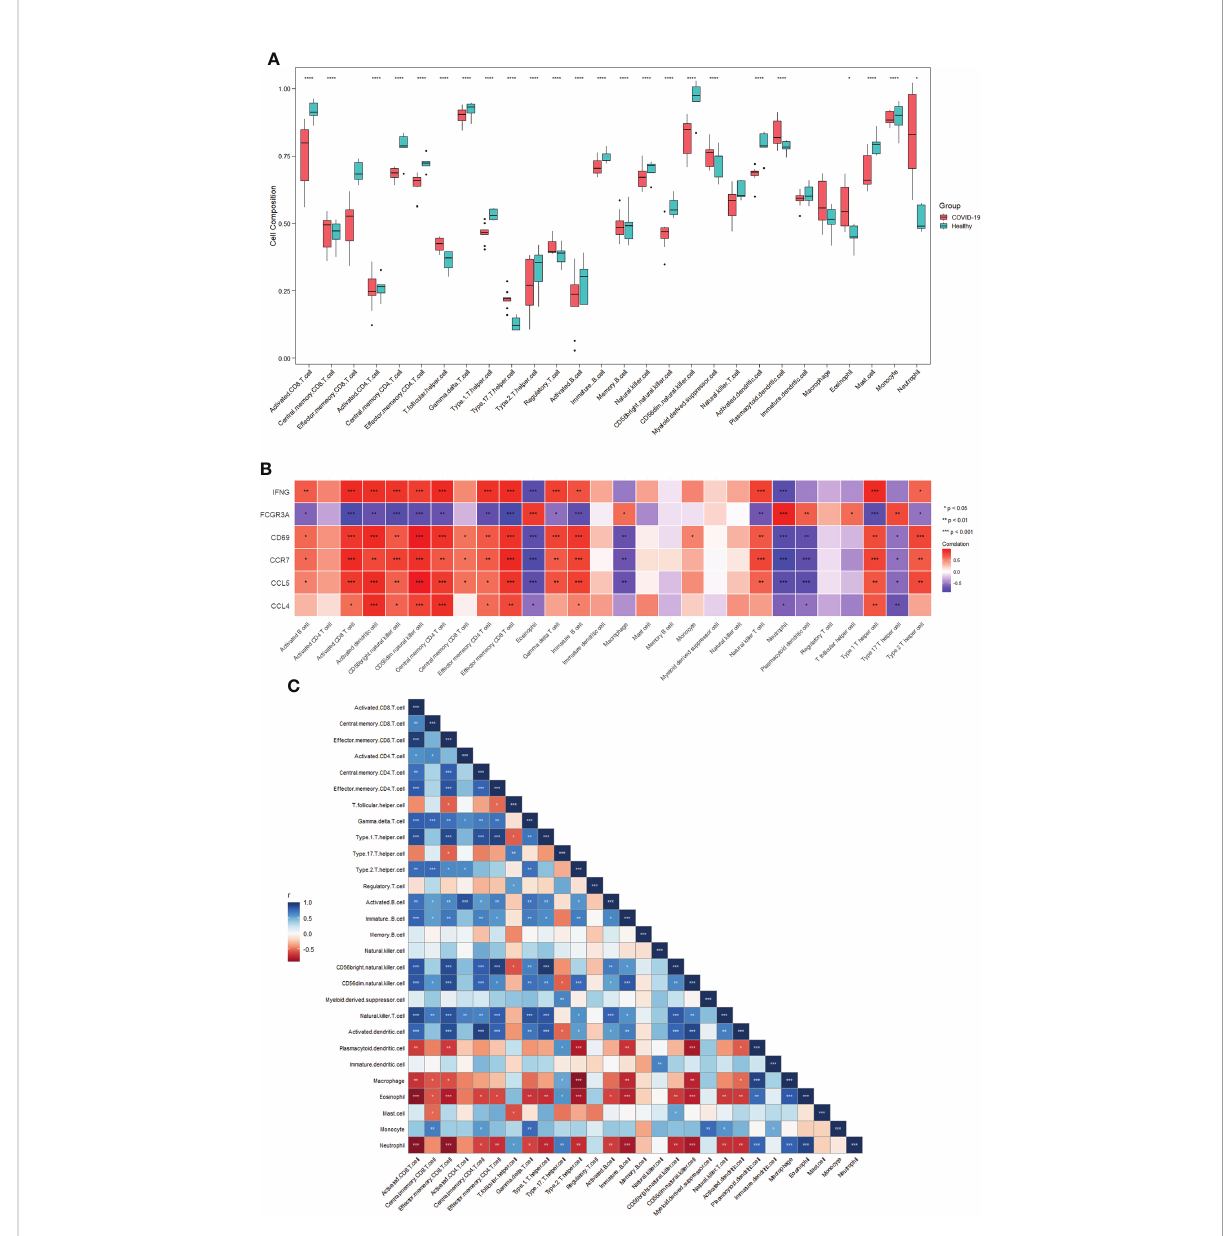
FIGURE 4 Immune cell in fi ltration analysis. (A) Distribution of 28 immune cells in the healthy and COVID-19 groups. (B) Correlations between six hub genes and different immune cells. Red color indicates positive correlation; blue color indicates negative correlation. (C) Correlation between 28 immune cells. Red indicates positive correlations; blue indicates negative correlations. *p<0.05, **p<0.01, ***p<0.001, ****p<0.0001. COVID-19: coronavirus disease